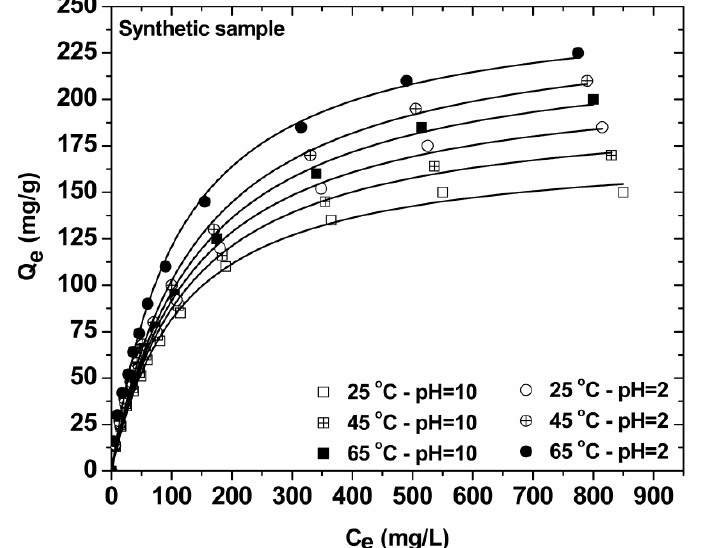
Figure 6. Isotherms of decolorization of synthetic dyeing solutions with COF (pH = 2, 10; 0–1000 mg/L total dye concentration; 1 g/L adsorbent; T = 25, 45, 65 °C; 140 rpm; 24 h